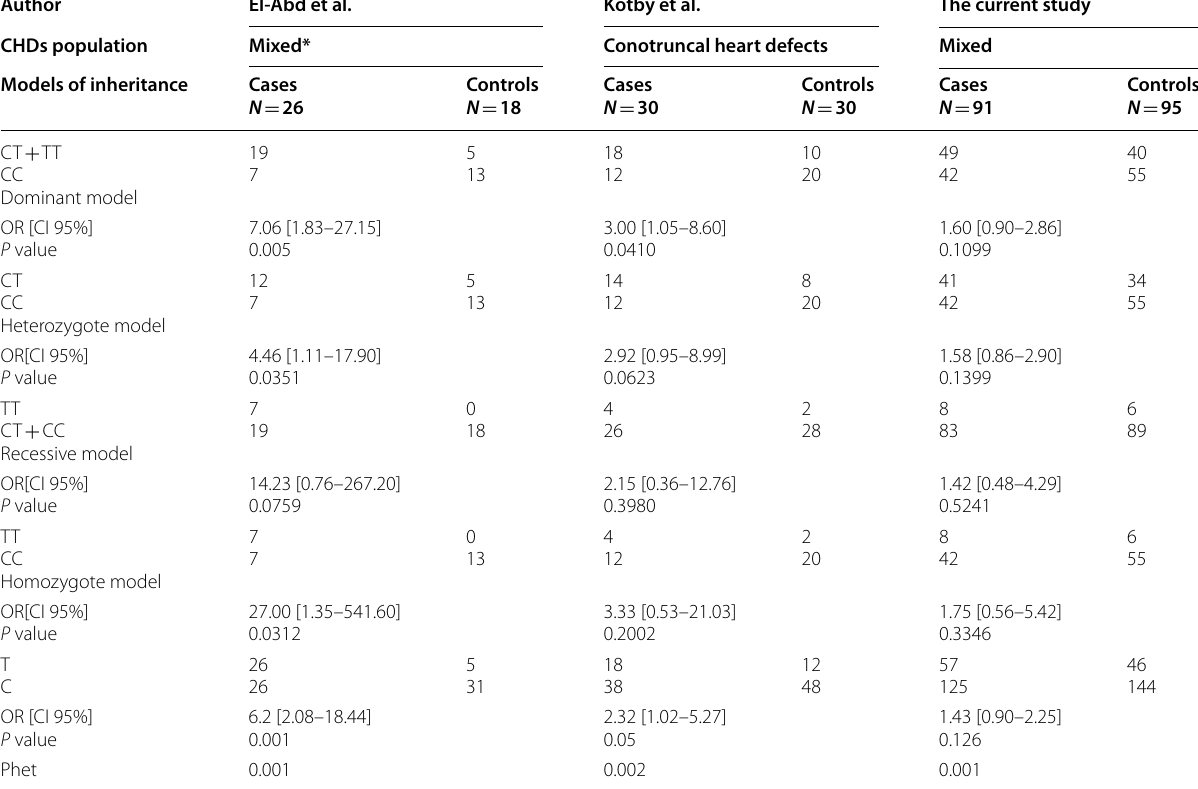
*“Mixed” means the authors’ subjects include conotruncal heart and cardiac septal defects in one study